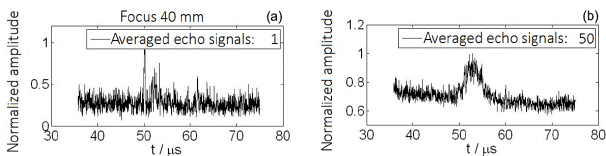
Figure 2. Normalized amplitude of averaged echo signals of an annular array at focusing Fok = 40mm in water of 30 ◦ C ( c = 1510ms − 1 ) for different numbers of averages (Maximum at t = 52µs).